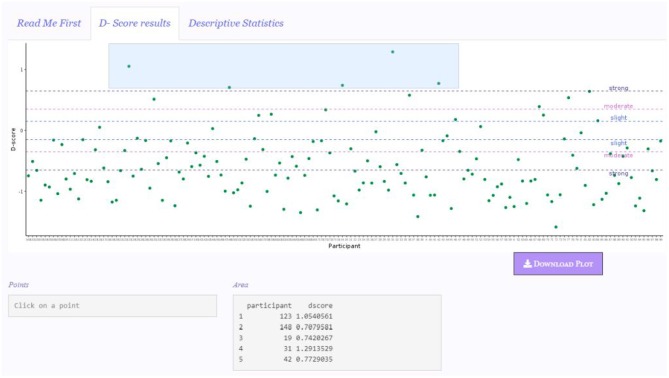
Area highlighter for detecting participants' D-score.